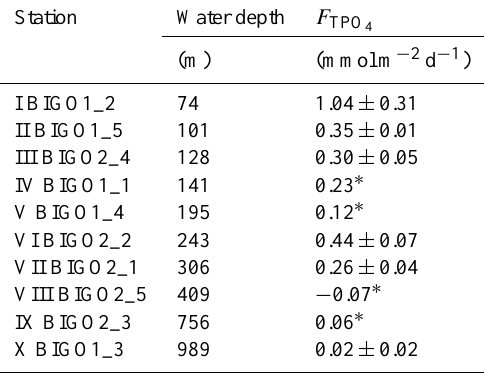
Table 3. In situ benthic chamber TPO 4 fluxes in mmolm − 2 d − 1 along the 12 ◦ S transect. The numbers are shown as an average and standard deviation calculated from the minimum and maximum fluxes determined from two benthic chambers.